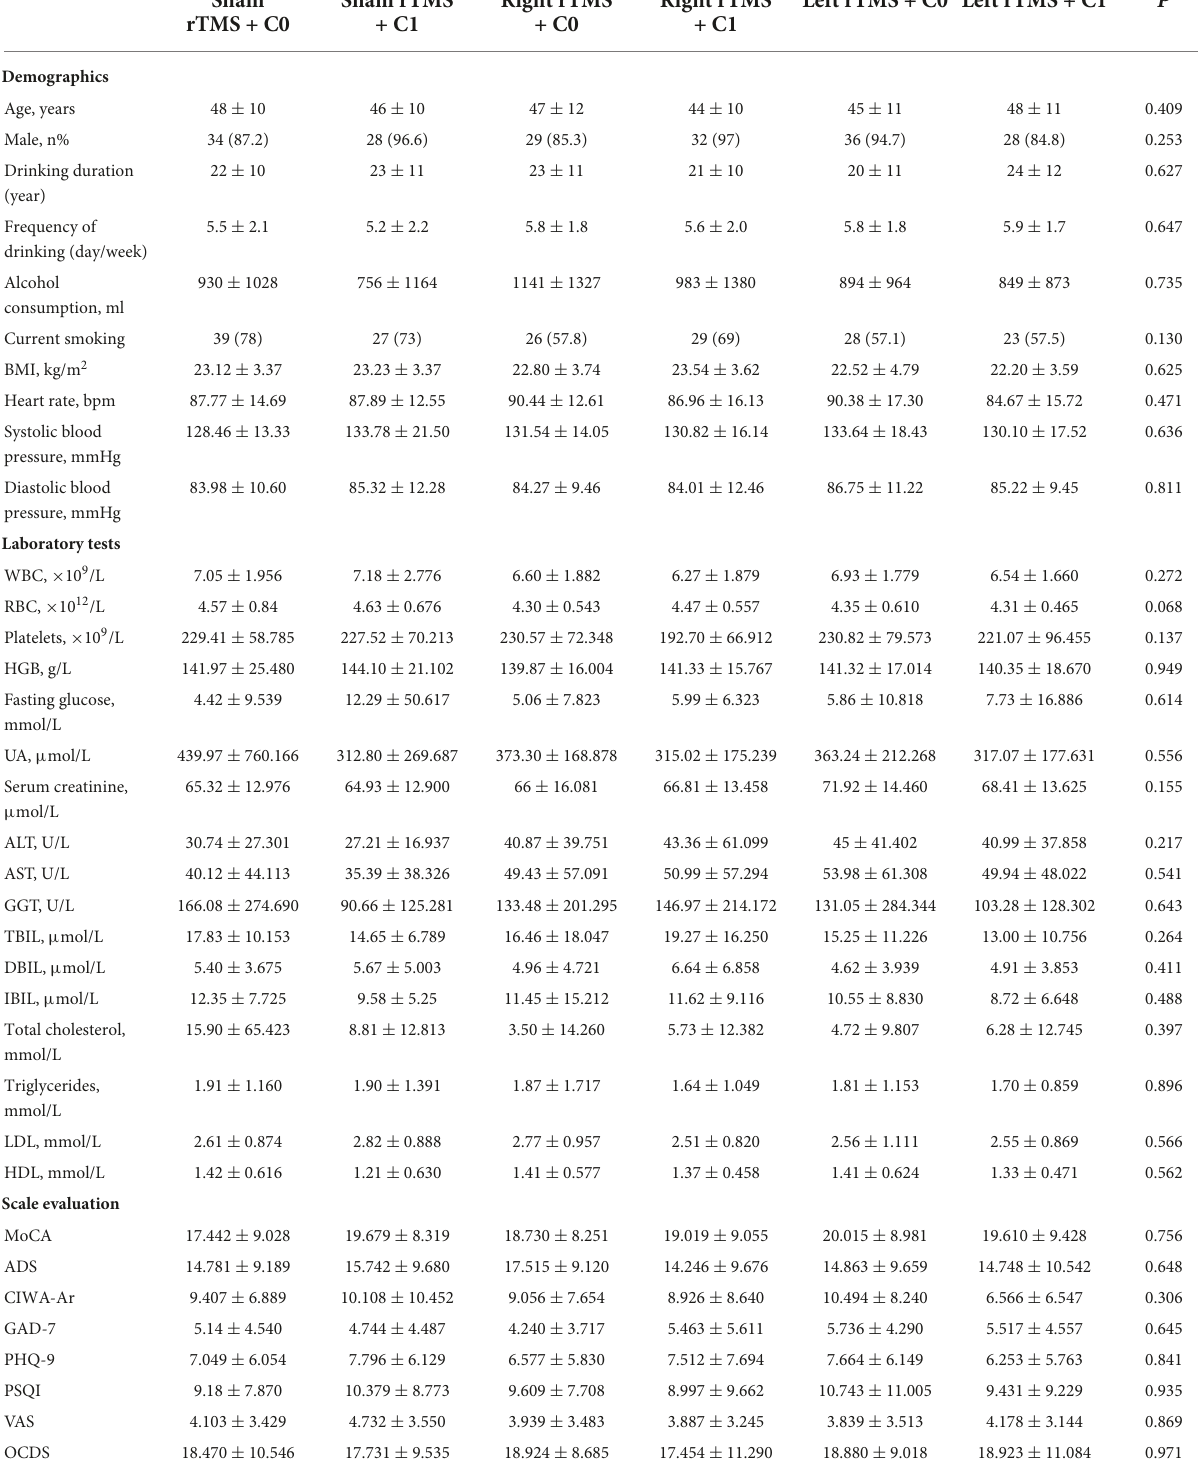
TABLE 1 Comparison of basic clinical information and laboratory test levels of patients recruited for the study.